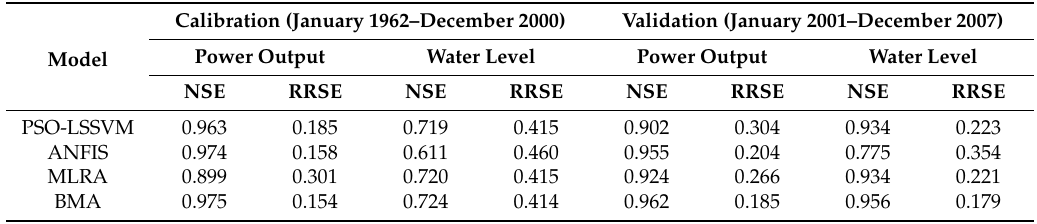
Table 10. The RRSE and NSE of the long-term power output/water level simulated by PSO-LSSVM, ANFIS, MLRA, and BMA